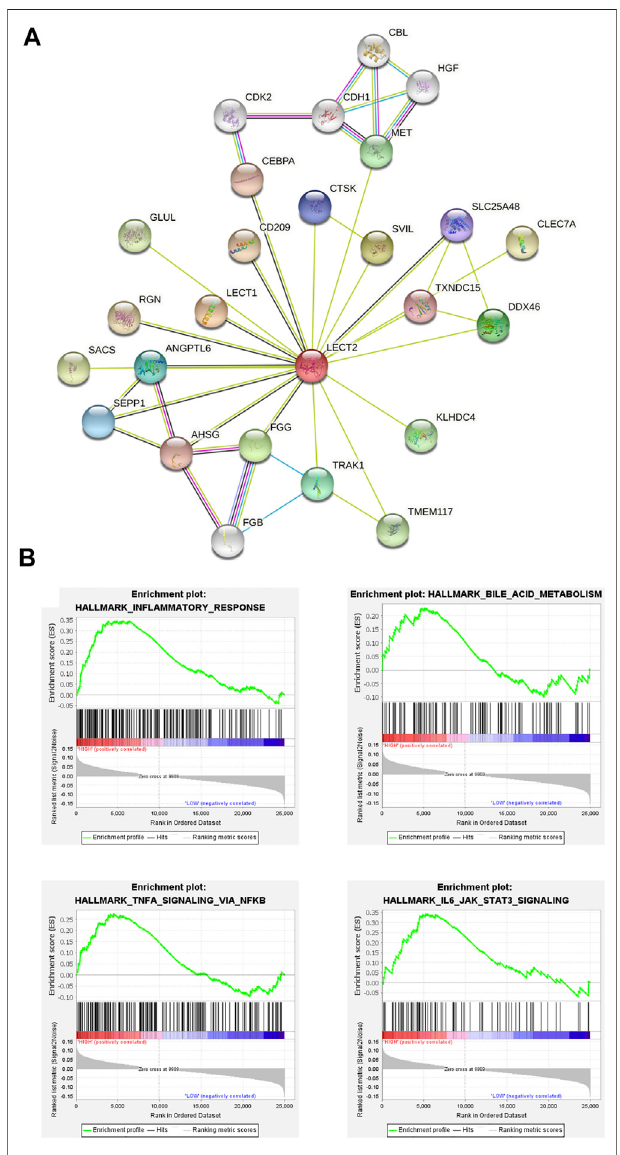
FIGURE 2 | Identi fi cation of hub genes (A) The protein – protein interaction (PPI) network (B) Gene set enrichment analysis.